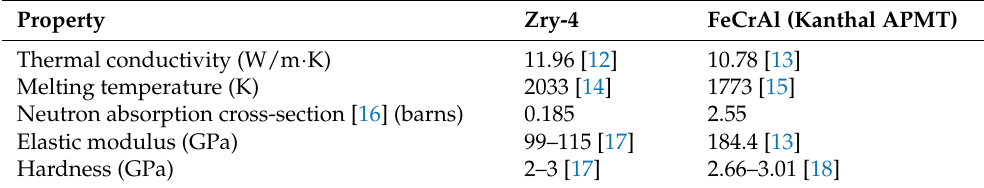
Table 1. Summary of key thermomechanical properties for Zry-4 and an alternative Fe-based alloy for LWR cladding applications,